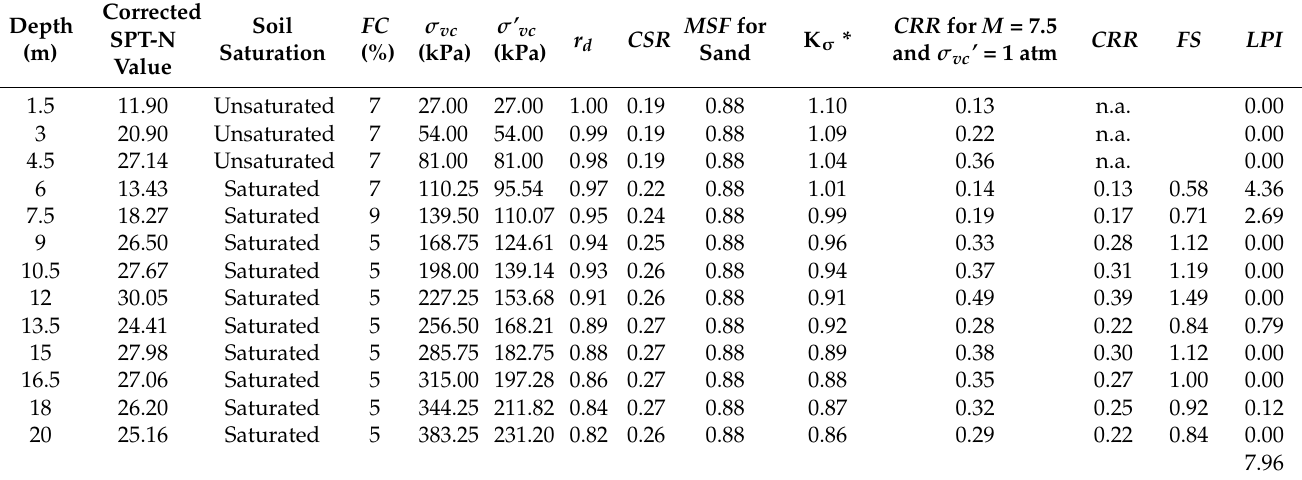
Figure 8. Typical soil profile, SPT-N value, and FS with depth at ( a ) Manamaiju, ( b ) Imadol, ( c ) Ramkot, and ( d ) Bungamati. Table 1. Sample calculation of FS and LPI for a typical